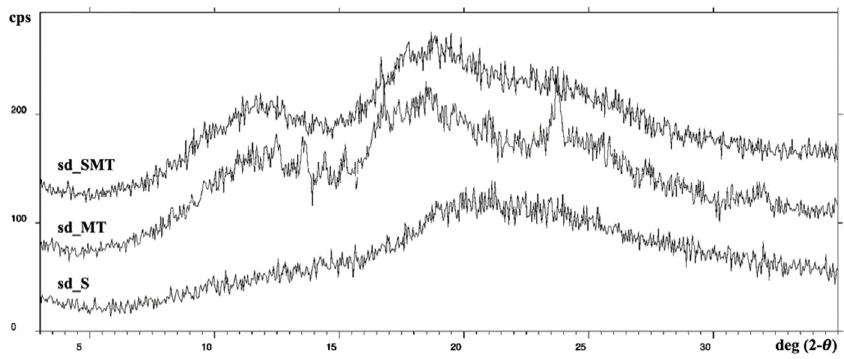
Figure 7. XRPD spectra of sd_S, sd_MT and sd_SMT powders.